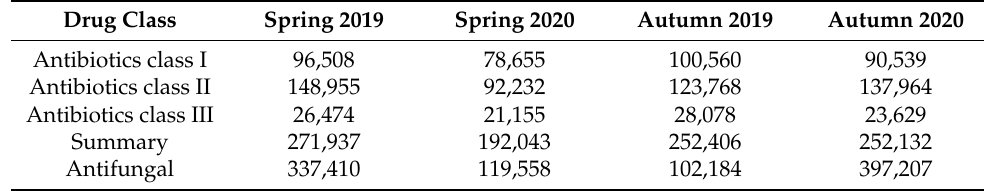
Table 10. Costs of antibiotics by category (PLN) (average exchange rate in 2020: 1 USD = 3.8972 PLN).